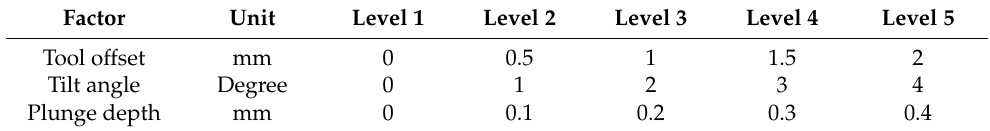
Table 5. Input factors and their levels.